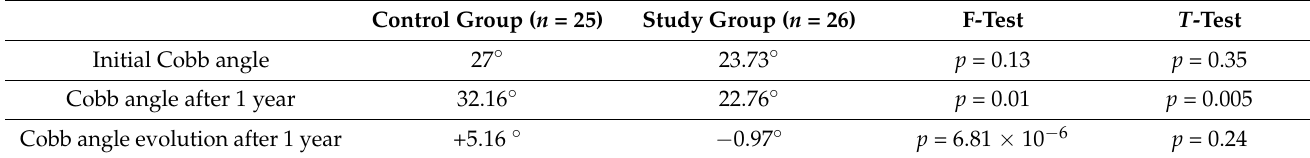
Table 2. Analysis of the Cobb angle between the study group and the control group upon initial starting point, after one year of treatment, and its evolution between these two intervals.